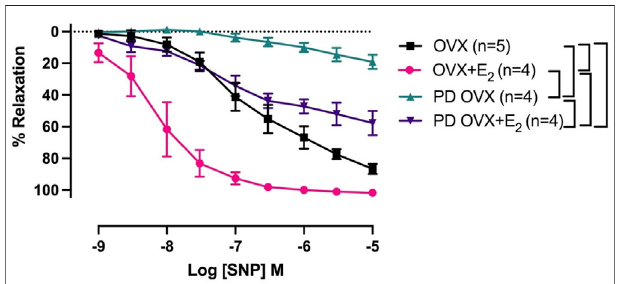
FIGURE 5 | Concentration-response curve (CRC) to sodium nitroprusside (SNP, 10 − 9 to 10 − 5 M) in intact mesenteric arterial rings precontracted with phenylephrine (PE, 2 μ M) from ovariectomized (OVX) and E 2 replaced (OVX+E 2 ) control and prediabetic (PD) rats. Data are expressed as mean α SEM. n = 4 – 5 per group. Brackets indicate signi fi cant differences ( p < 0.05) between groups, analyzed using 2-way ANOVA with repeated measures followed by Tukey ’ s post hoc test.